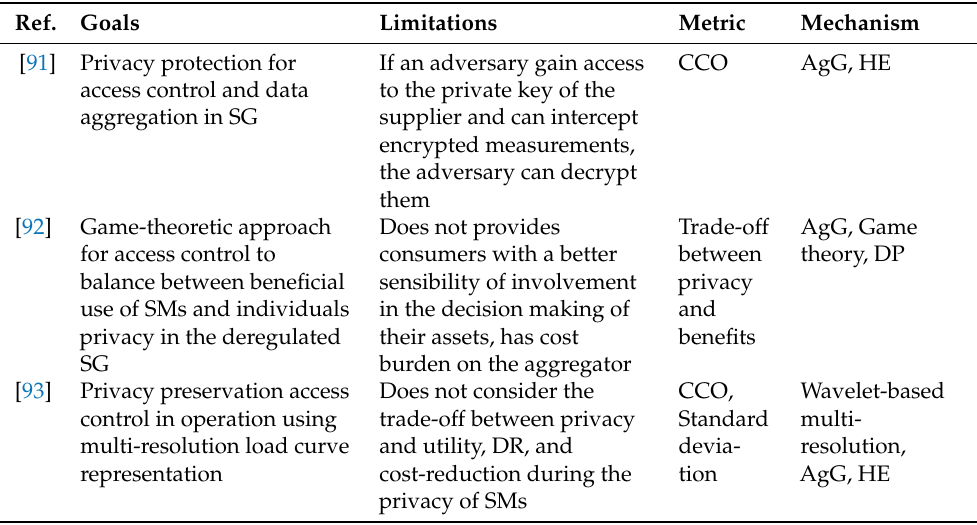
Table 5. Summary of SM privacy-preservation techniques for access control in operation against weak adversaries without